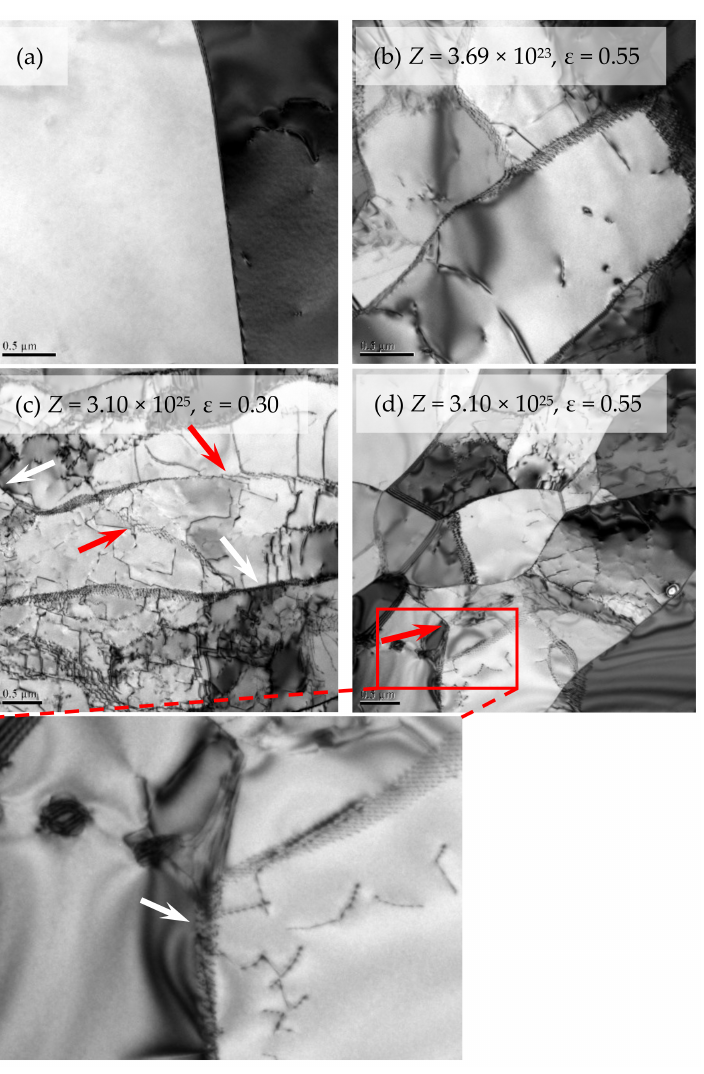
Figure 10. TEM analyses of the initial microstructure ( a ) and dynamic microstructures ( c – d ) after deformation at different deformation conditions.